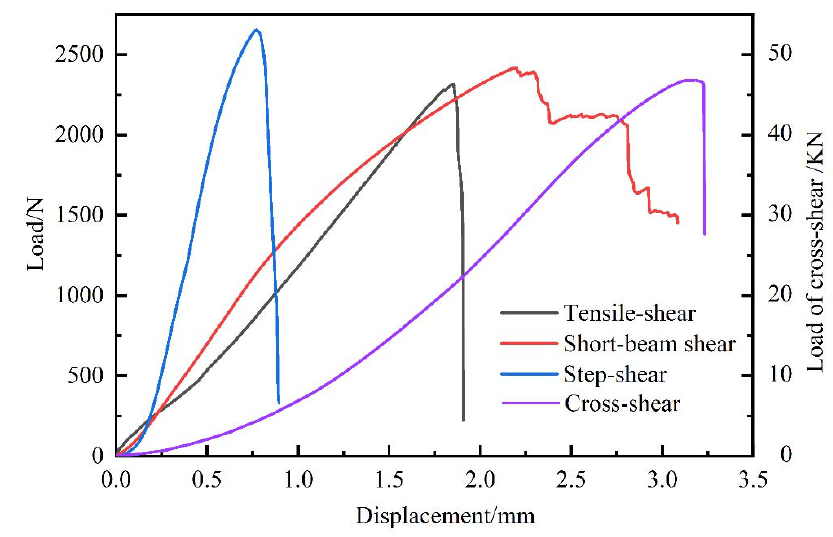
Figure 3. Typical load-displacement curves in four test methods.